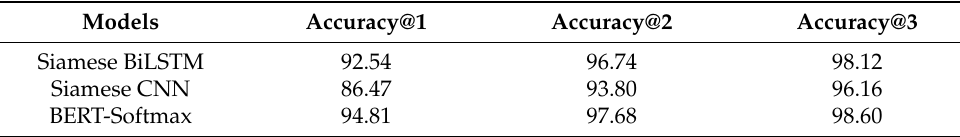
Table 6. Predicate Mapping.